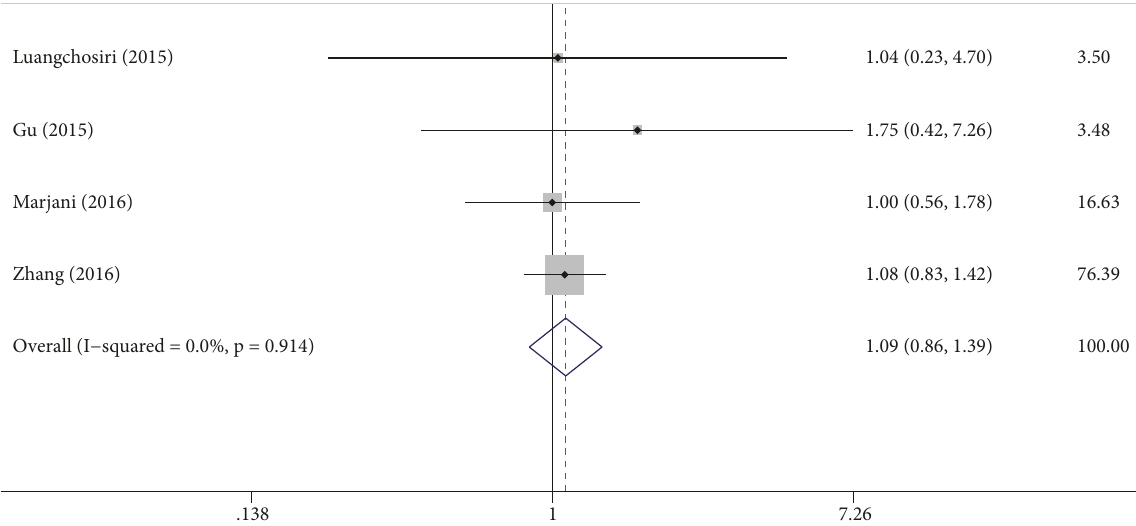
Figure 5: Effect of silymarin on adverse events in patients undergoing anti-TB